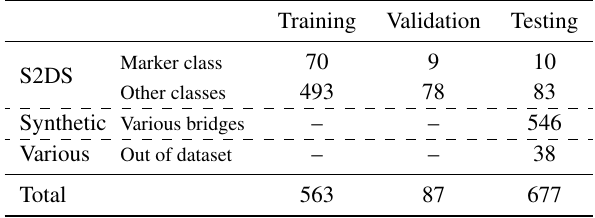
Table 1. Images used for training, validation, and